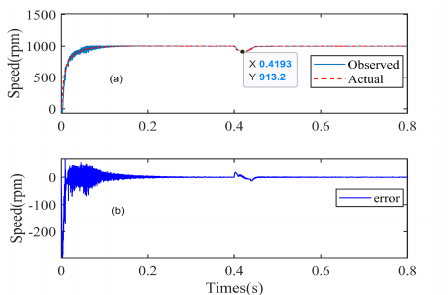
Figure A3. The speed response of VPDPI regulator when R s = 0.031 and J = 0.0008. ( a ) Observed speed and actual speed. ( b ) Estimation error curve